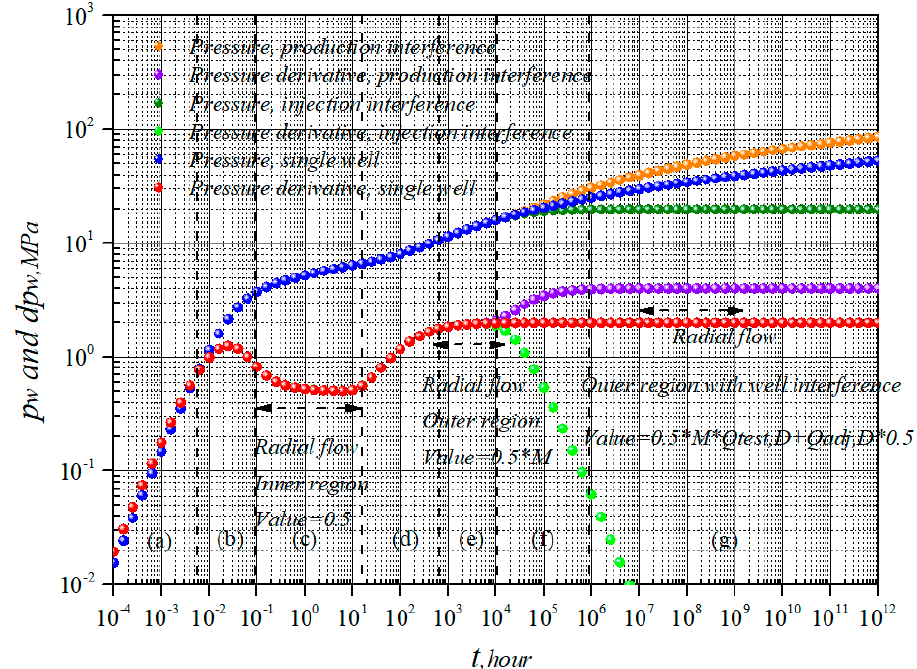
Figure 5. Flow regimes in the multi-well system with a radially composite reservoir and well interference during UGS. The pressure behaviors of the single well model are used for comparison.